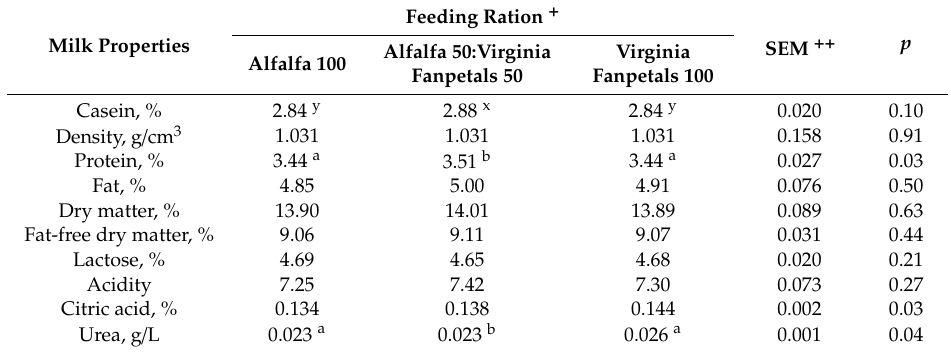
Table 6. Physicochemical parameters and selected chemical components of milk from lactating cows fed di ff erent silage-diets.